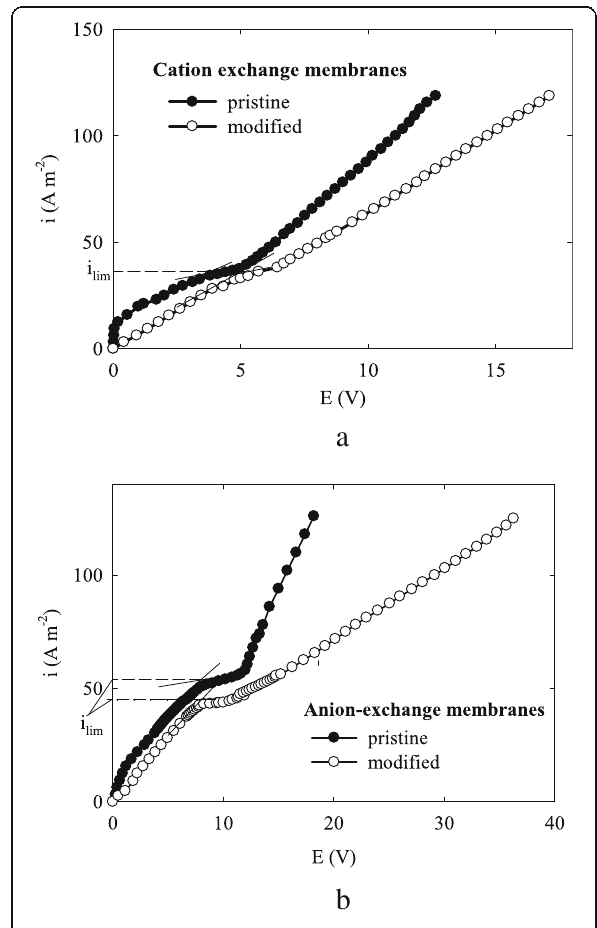
Fig. 7 Voltammetric curves for cation-exchange a and anion-exchange b membranes. The measurements were performed in aqueous solution containing 40 mol m − 3 NaCl, superficial flow